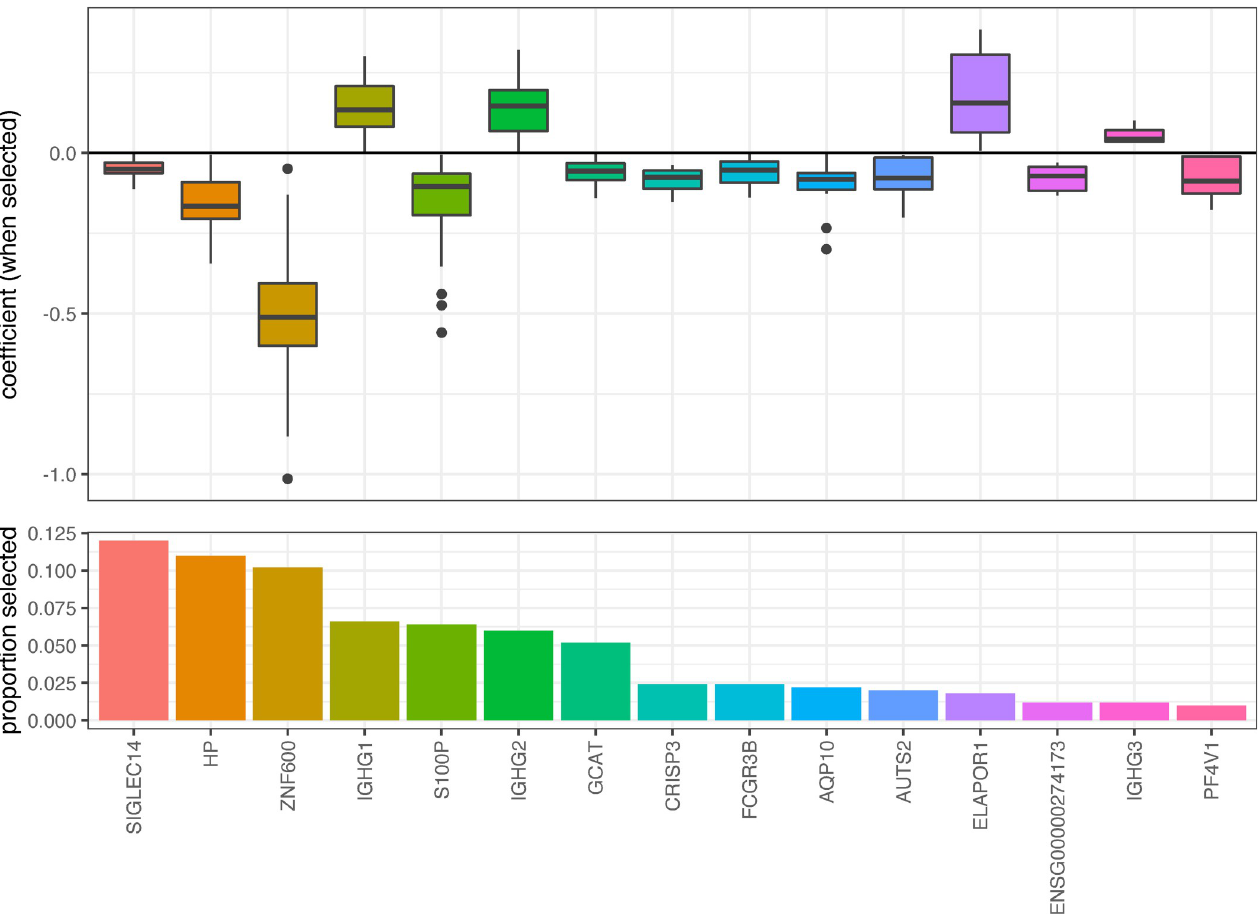
Fig 6. Genes selected in LASSO regression analysis of allograft rejection. Boxplots in the upper panel represent the coefficient value of each transcript and bar plots in the lower panel indicate transcription selection proportion. There are no clear trends in coefficient values as the selection proportion decreases. Genes selected included those involved in immune system activation and hemostasis.